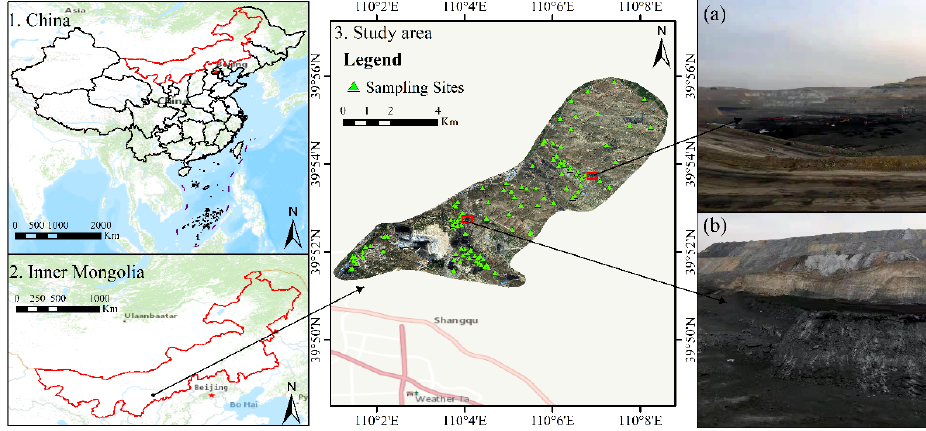
Figure 2. The map of soil sampling sites; ( a ) and ( b ) show photos of the areas of the sampling